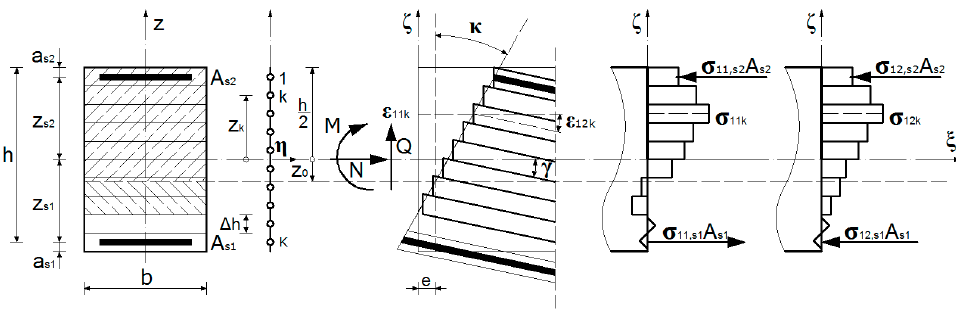
Figure 5. Model of the reinforced concrete cross-section.